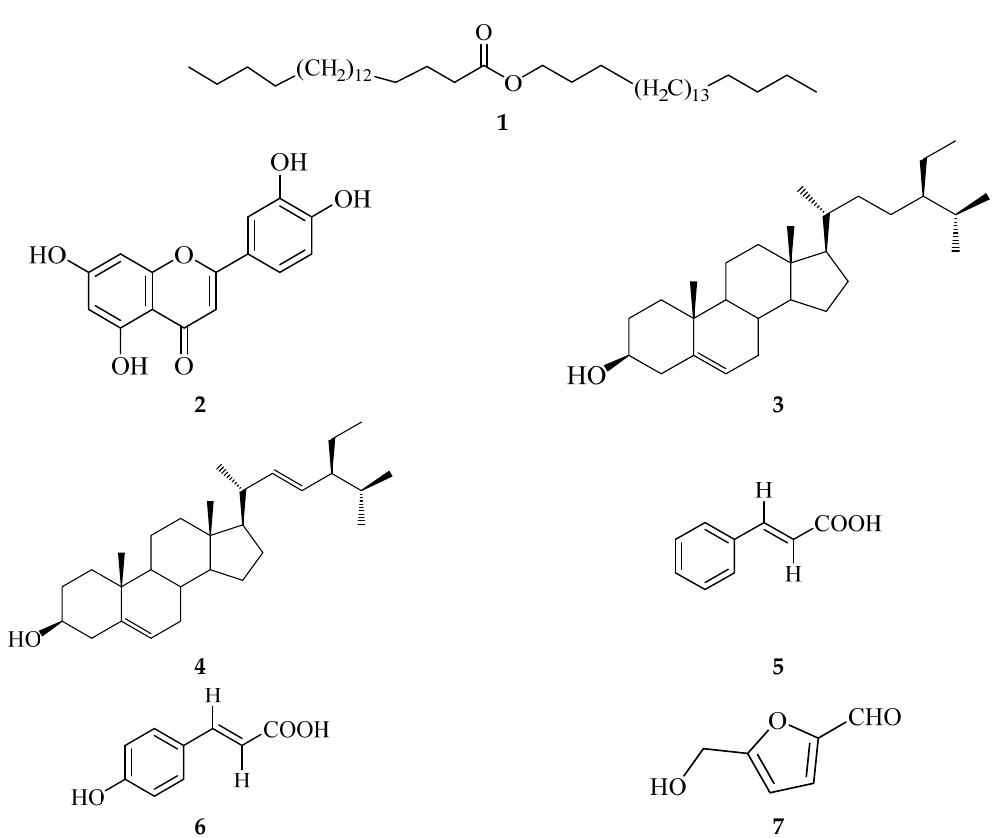
Figure 2. The chemical structure of the isolated compounds of C. timoriensis flowers and C. grandis pods.